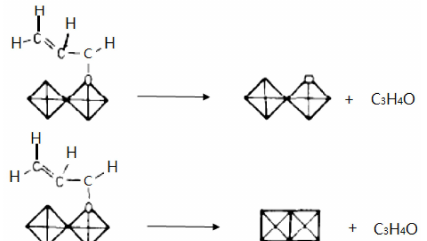
Figure 1. Schematic representation of the mechanism of O insertion into a hydrocarbon molecule (left) and its consequences in creation of a reversible O vacancy in a metal oxide (right) P 2 O 74 ´ + O 2 ´ Ø 2 PO 43 ´ . Reproduced from [11]. Copyright 2015, Academic Press.